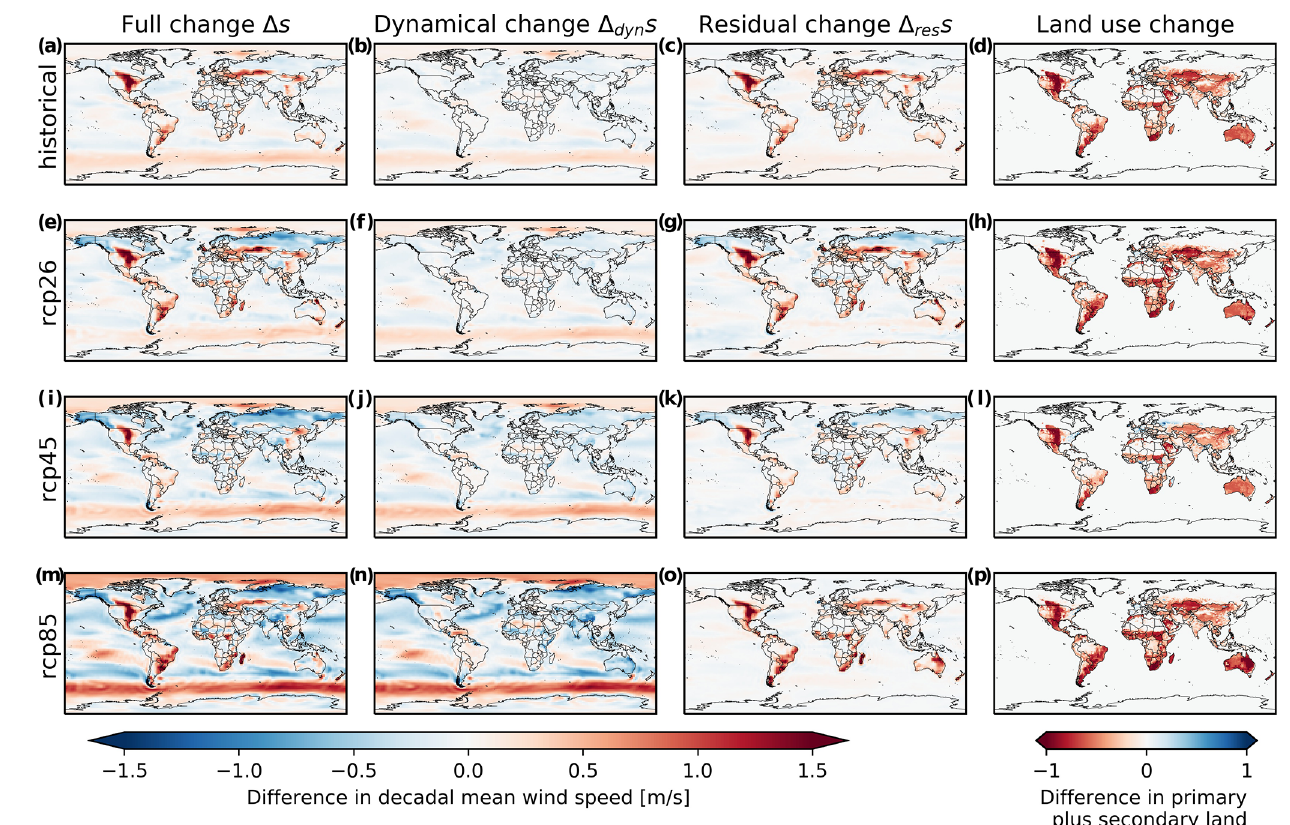
Figure 1. Near-surface wind speed changes in the MPI-GE ensemble mean and change in primary plus secondary land in LUH1. Changes are expressed relative to the beginning of the historical period (1850–1860). Each row represents one experiment (historical, rcp2.6, rcp4.5, rcp8.5) and values are shown for the last complete decade in each experiment (i.e., 1990–2000 in historical and 2090–2100 for the rcp’s). Panels (a, e, i, m) show the full change (i.e., the change in wind speeds in the respective experiment), (b, f, j, n) show the dynamical change due to CO 2 forcing only (calculated from the 1% CO 2 experiments during decades including the years given in Table 1), and (c, g, k, o) show the difference between (a, e, i, m) and (b, f, j, n) which we refer to as residual. Panels (d, h, l, p) denote land use